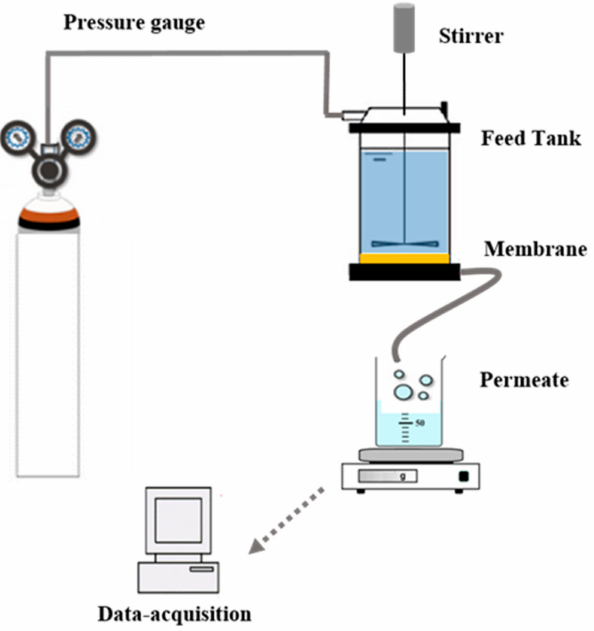
Figure 1. Illustration of the experimental setup for treating the